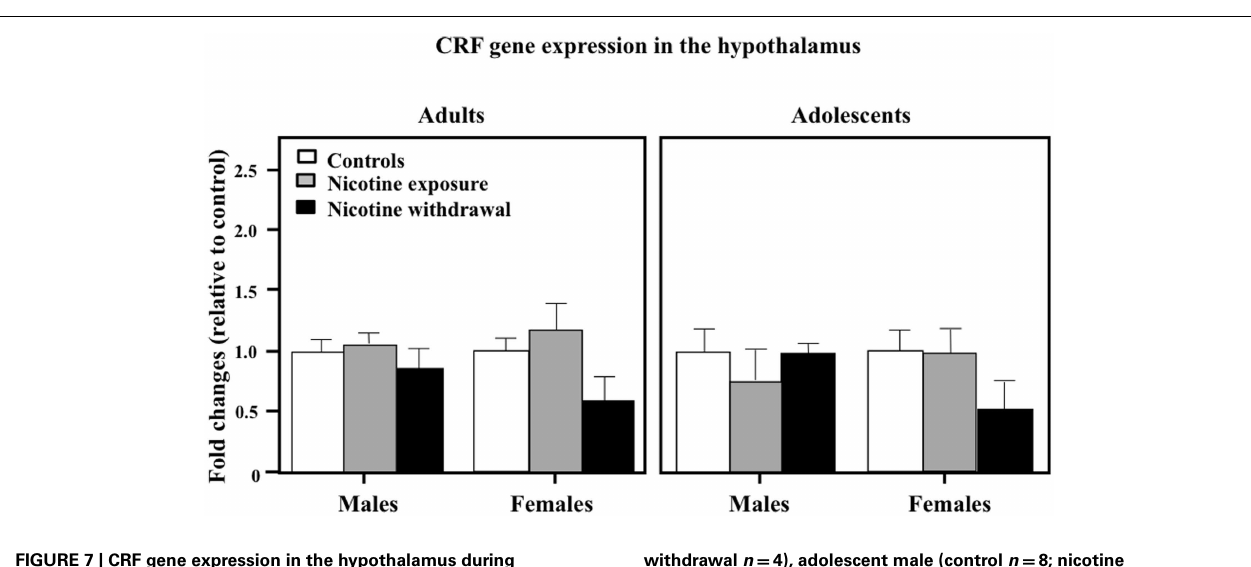
FIGURE 7 | CRF gene expression in the hypothalamus during nicotine exposure and withdrawal in adult male (control n = 13; nicotine exposure n = 13; nicotine withdrawal n = 6), adult female (control n = 6; nicotine exposure n = 6; nicotine